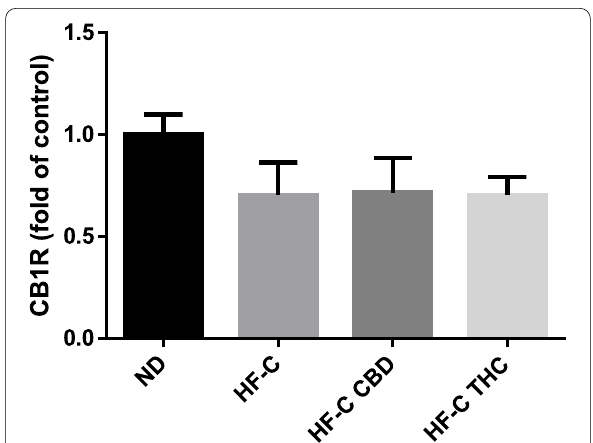
Fig. 8 Effect of THC or CBD treatment on CB1 receptor gene expression in the liver of mice fed HFCD. Male C57BL/6J mice aged 7–8 weeks were fed either normal diet (ND, n 8), high fat = + 1%(w/w) cholesterol 0.5%(w/w) cholate diet (HF‑C, n 8), HFCD + = containing CBD (2.39 mg/kg) (HF‑C CBD, n 8), HFCD containing = THC (2.5 mg/kg) (HF‑C THC, n 8). At the conclusion of the = experiment, RNA was isolated from harvested livers and gene levels quantified using qPCR. Values are expressed as relative expression compared to ND (mean SEM) ±